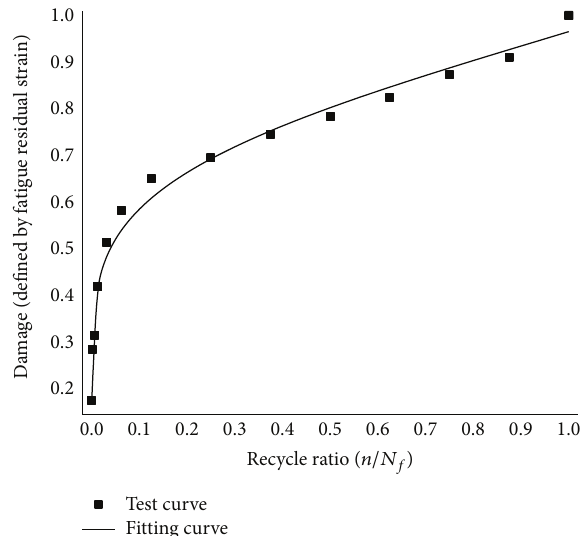
Figure 7: Damage result of JL-3 based on maximum fatigue strain.